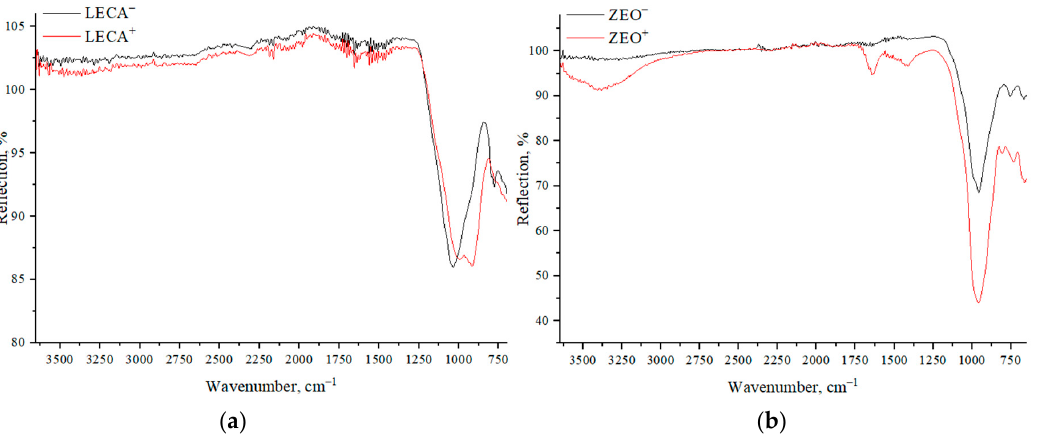
Figure 3. IR spectra of materials studied before and after biofouling: LECA ( a ) and zeolite ( b ).